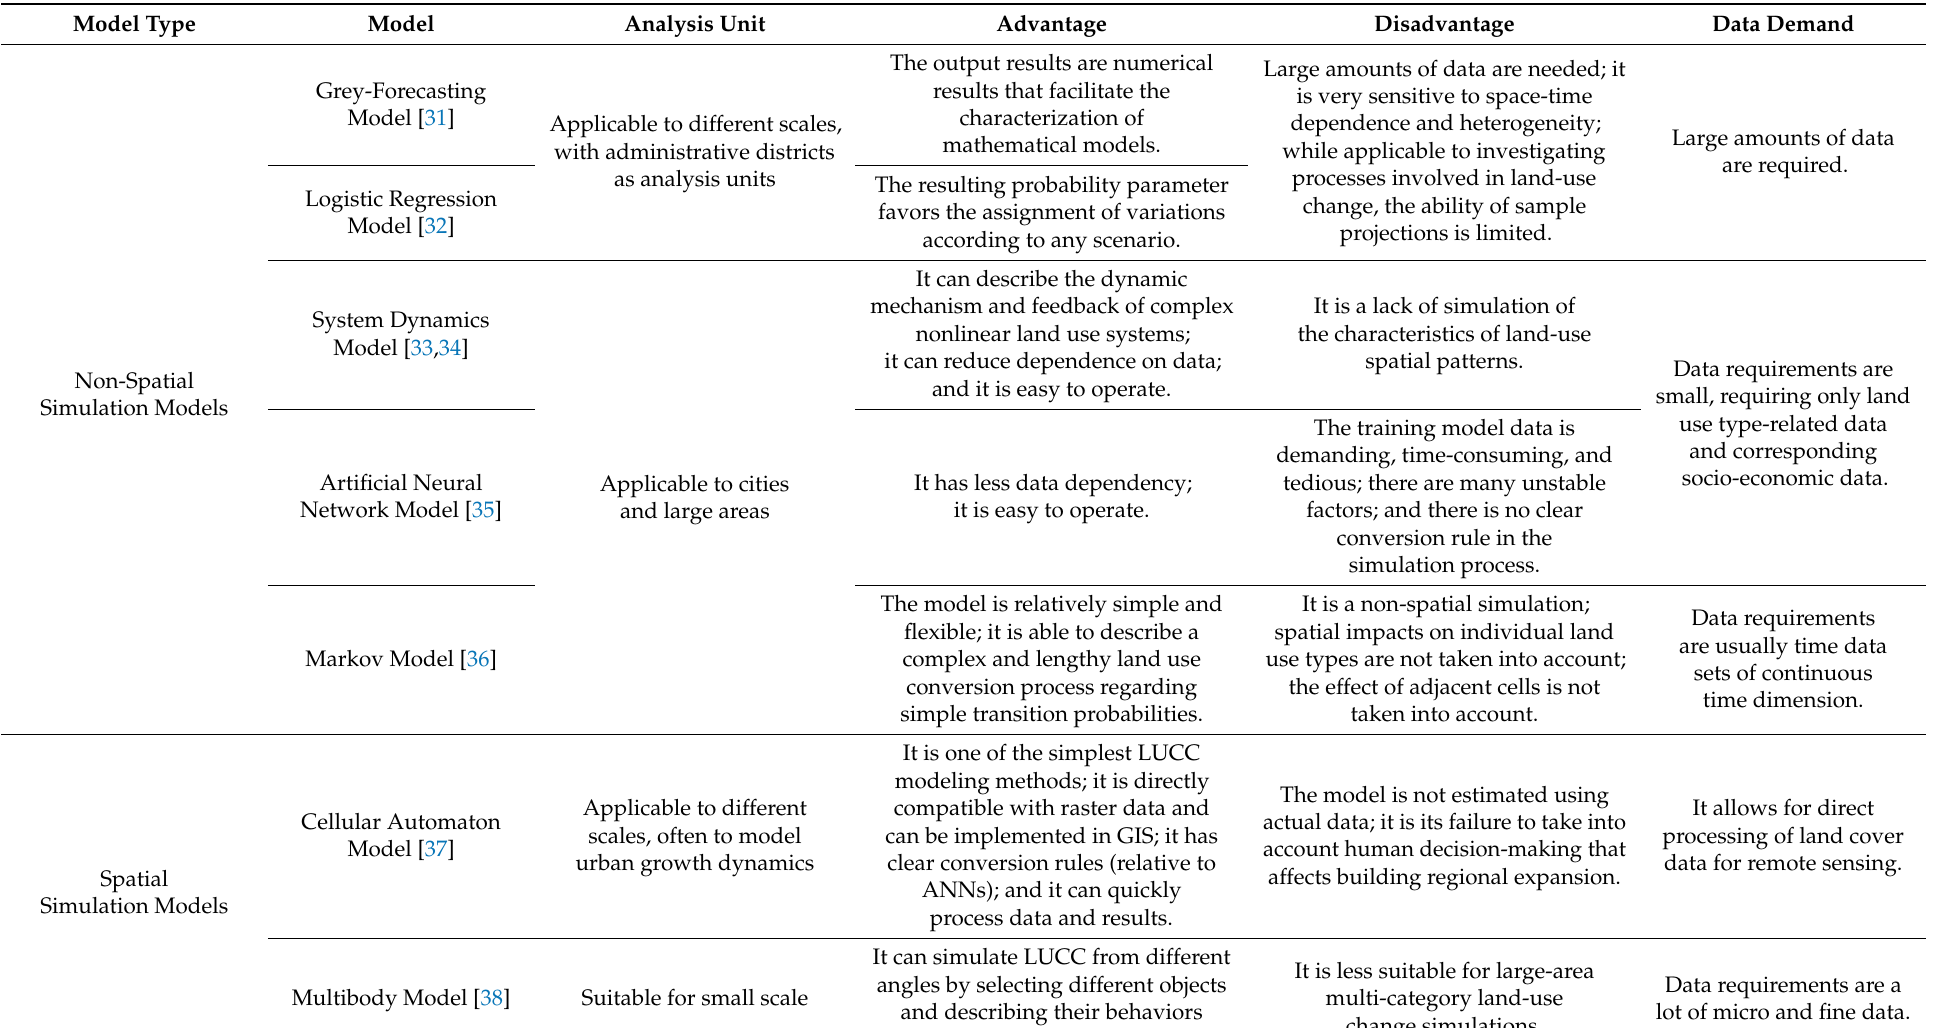
Table 1. Summary of Land Use Simulation